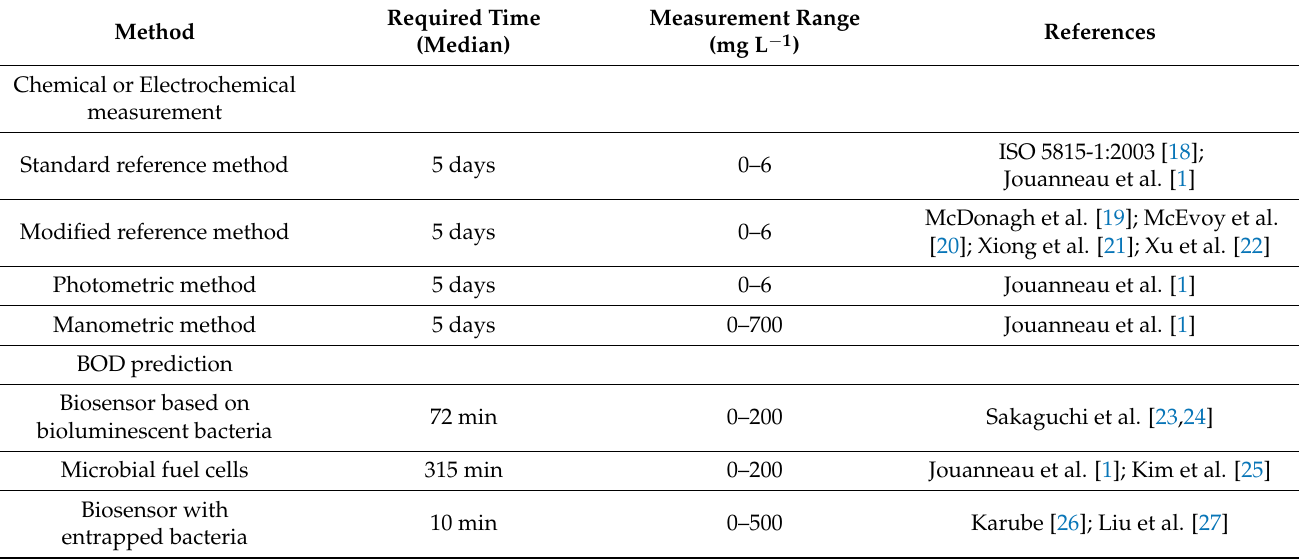
Table 1. Groups of main methods for determining BOD, required time and measurement range for each